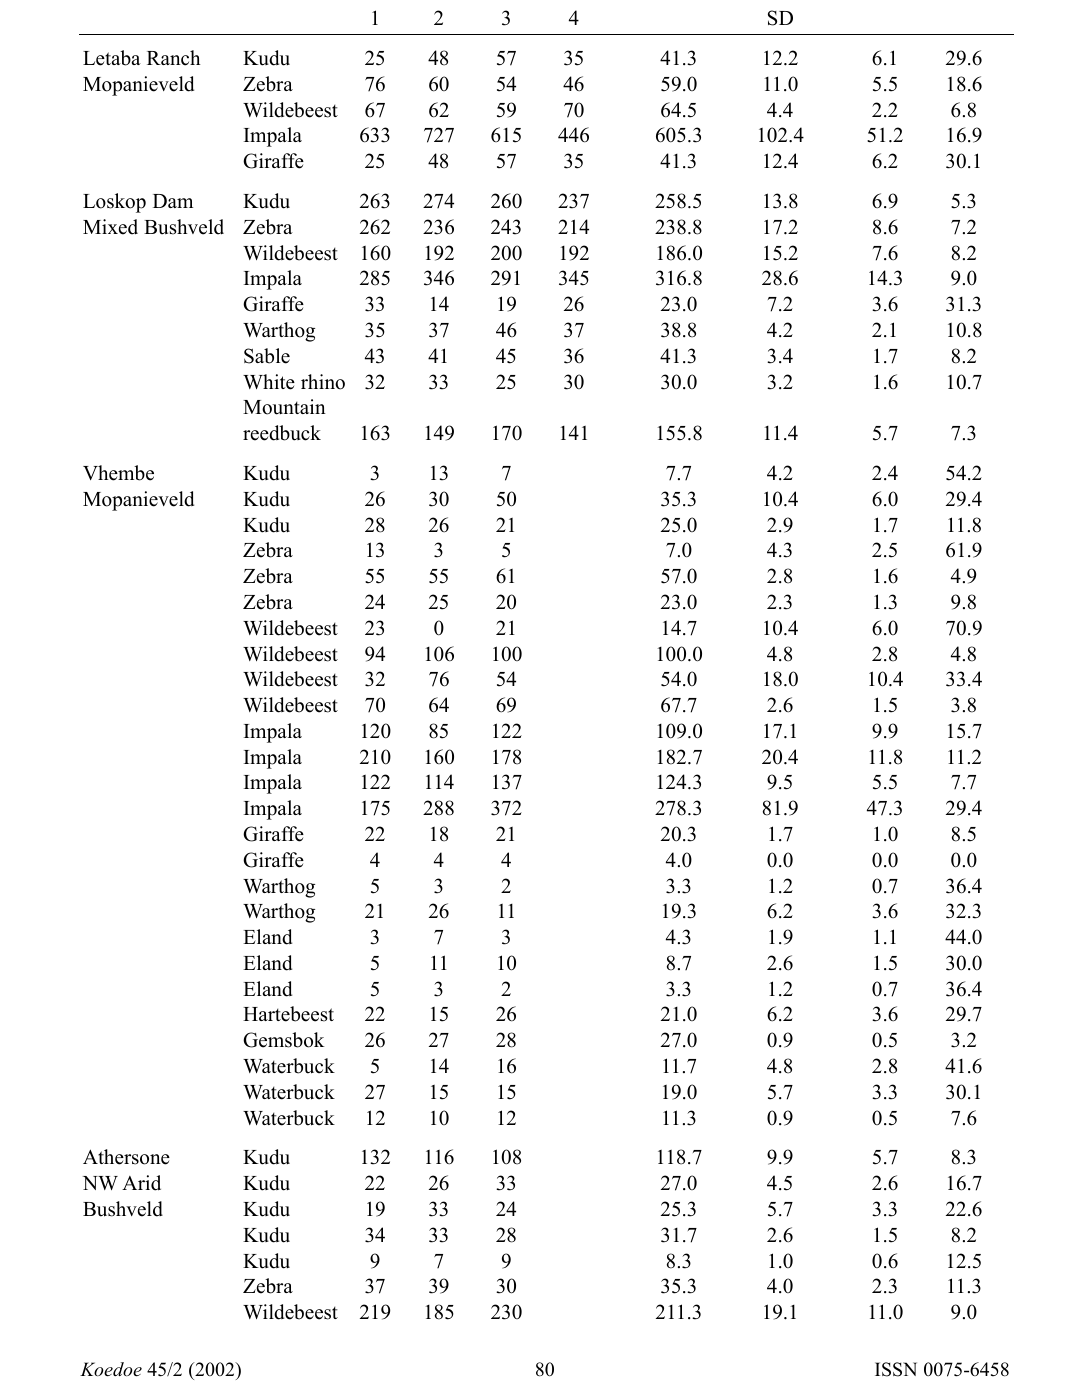
Summary precision data for 61 observations during this